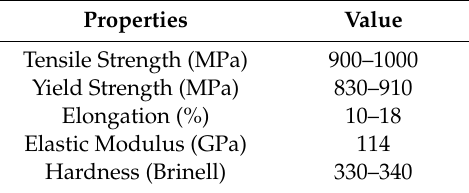
Table 2. Mechanical properties of Ti6Al4V Alloy.